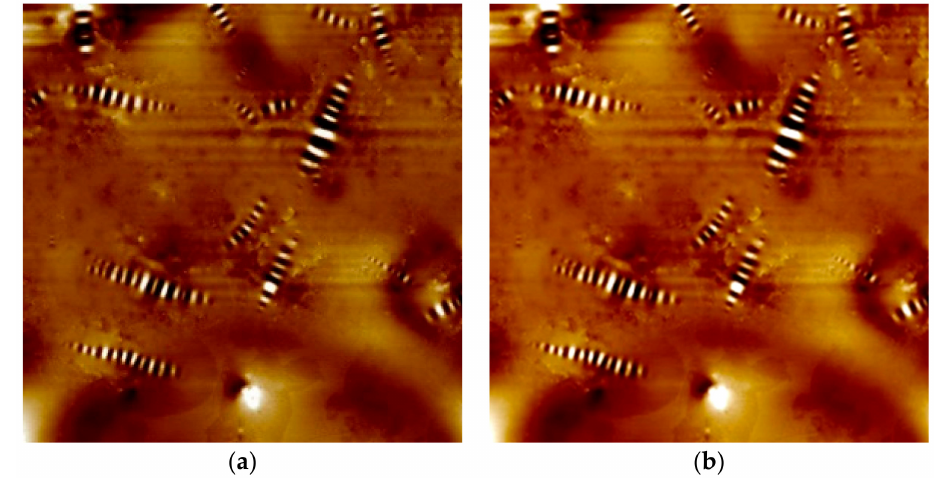
Figure 6. Color scale adjustment; ( a ) original image ( b ) color rescaled